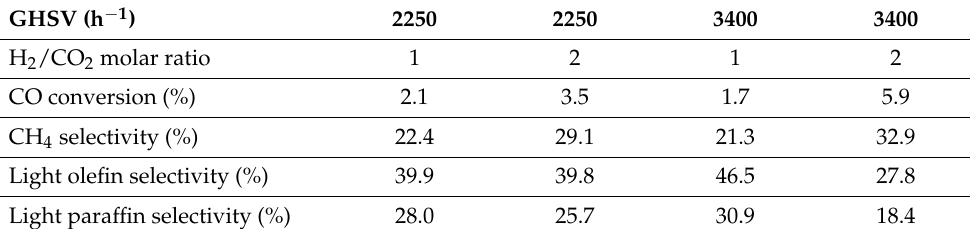
Table 3. Effect of GHSV and H 2 /CO 2 ratio on CO conversion and product selectivities.